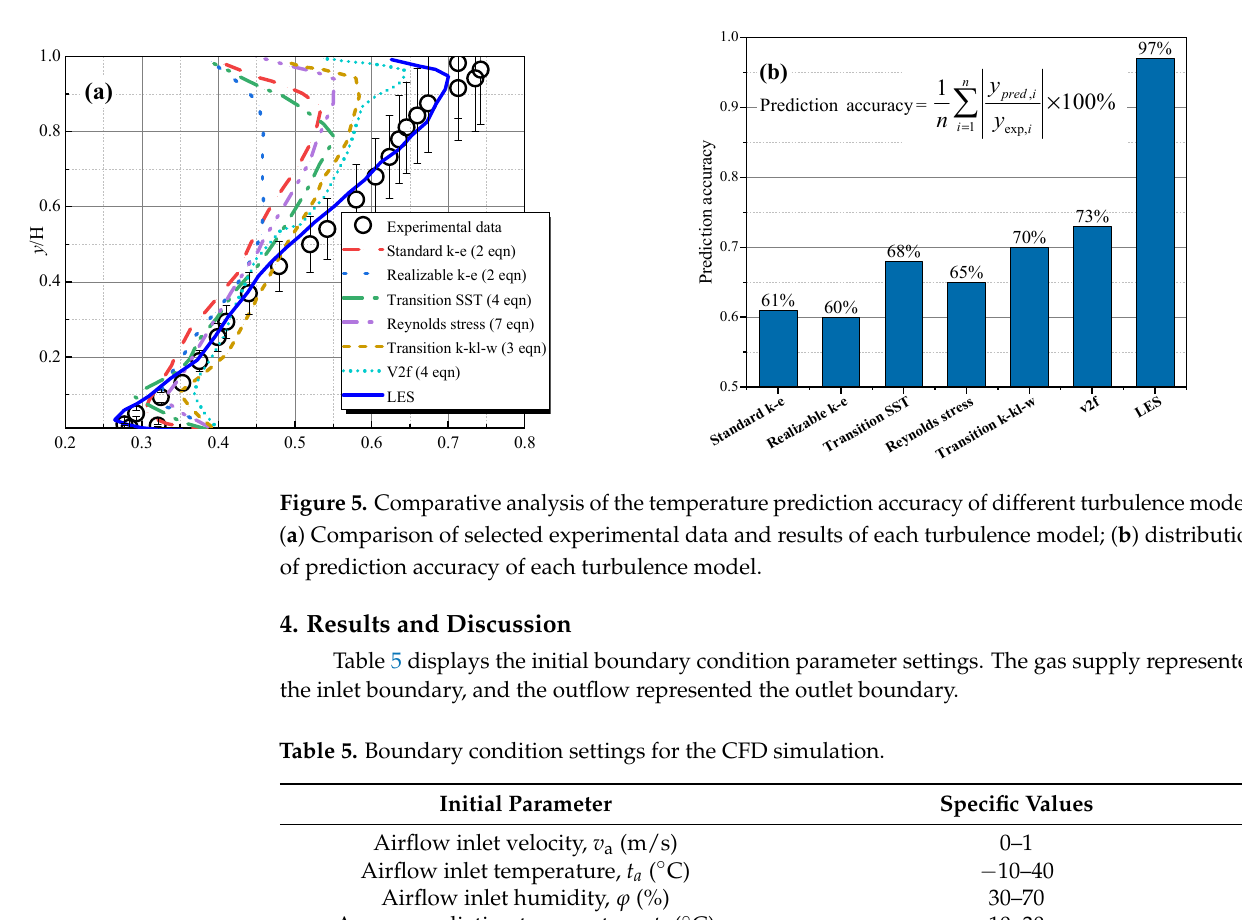
Table 6. Initial boundary conditions for numerical simulation.